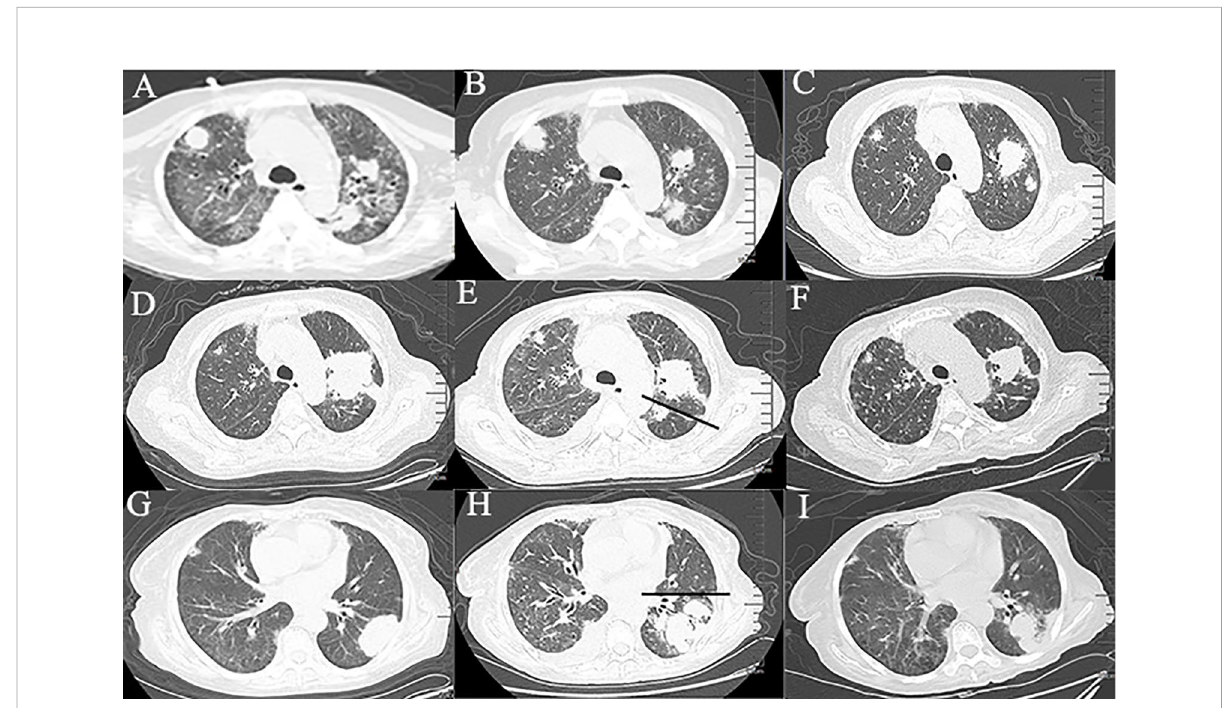
FIGURE 1 Chest computed tomography at different time periods. (A ‒ C) Changes of ground-glass opacities, patchy shadows, and multiple nodules in both lungs within 50 days. (D, E) Changes of masses in the upper lobe of the left lung within 20 days. (The straight line indicates the left interlobar fi ssure). (G, H) Changes of the masses in the lower lobe of the left lung within 20 days. (The straight line indicates the interlobar fi ssure). (F, I) Imaging fi ndings after 2 courses of